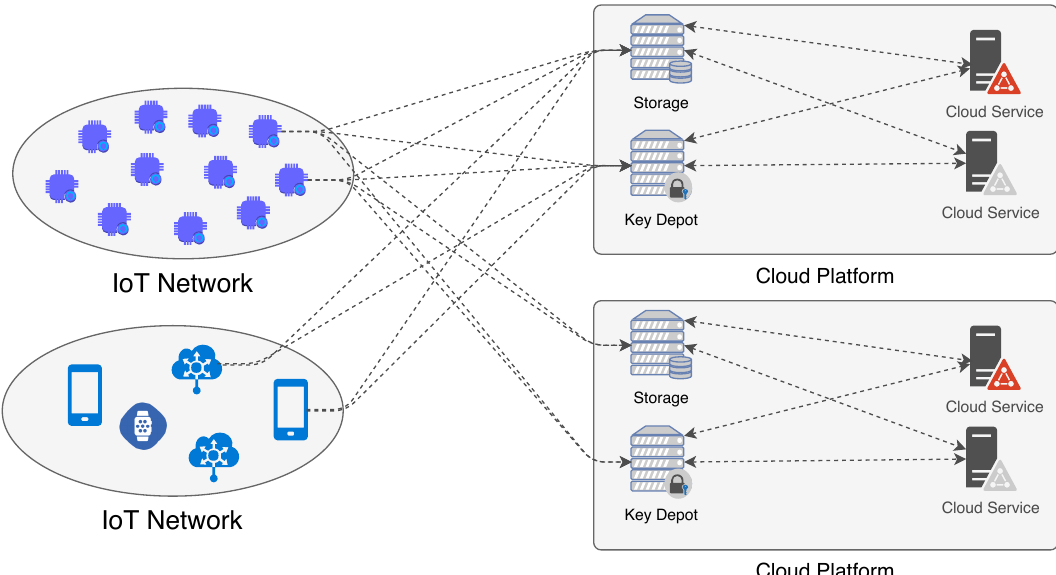
Figure 1. PROTeCt ( P rivacy a R quitecture for integrati O n of internet of T hings and C loud computing): Internet of Things (IoT) devices send encrypted data to one or more cloud platform, and authorized cloud services access it to provide useful applications to